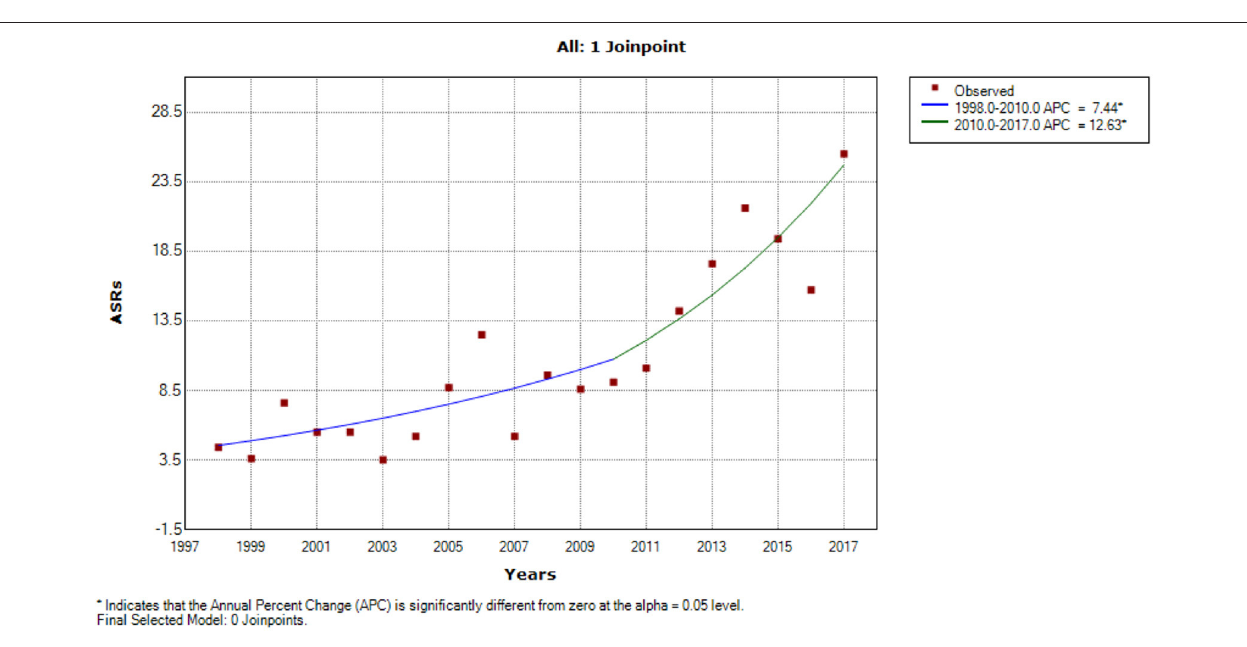
FIGURE 2 | Prostate cancer risk annual percentage change over time; 1998–2017